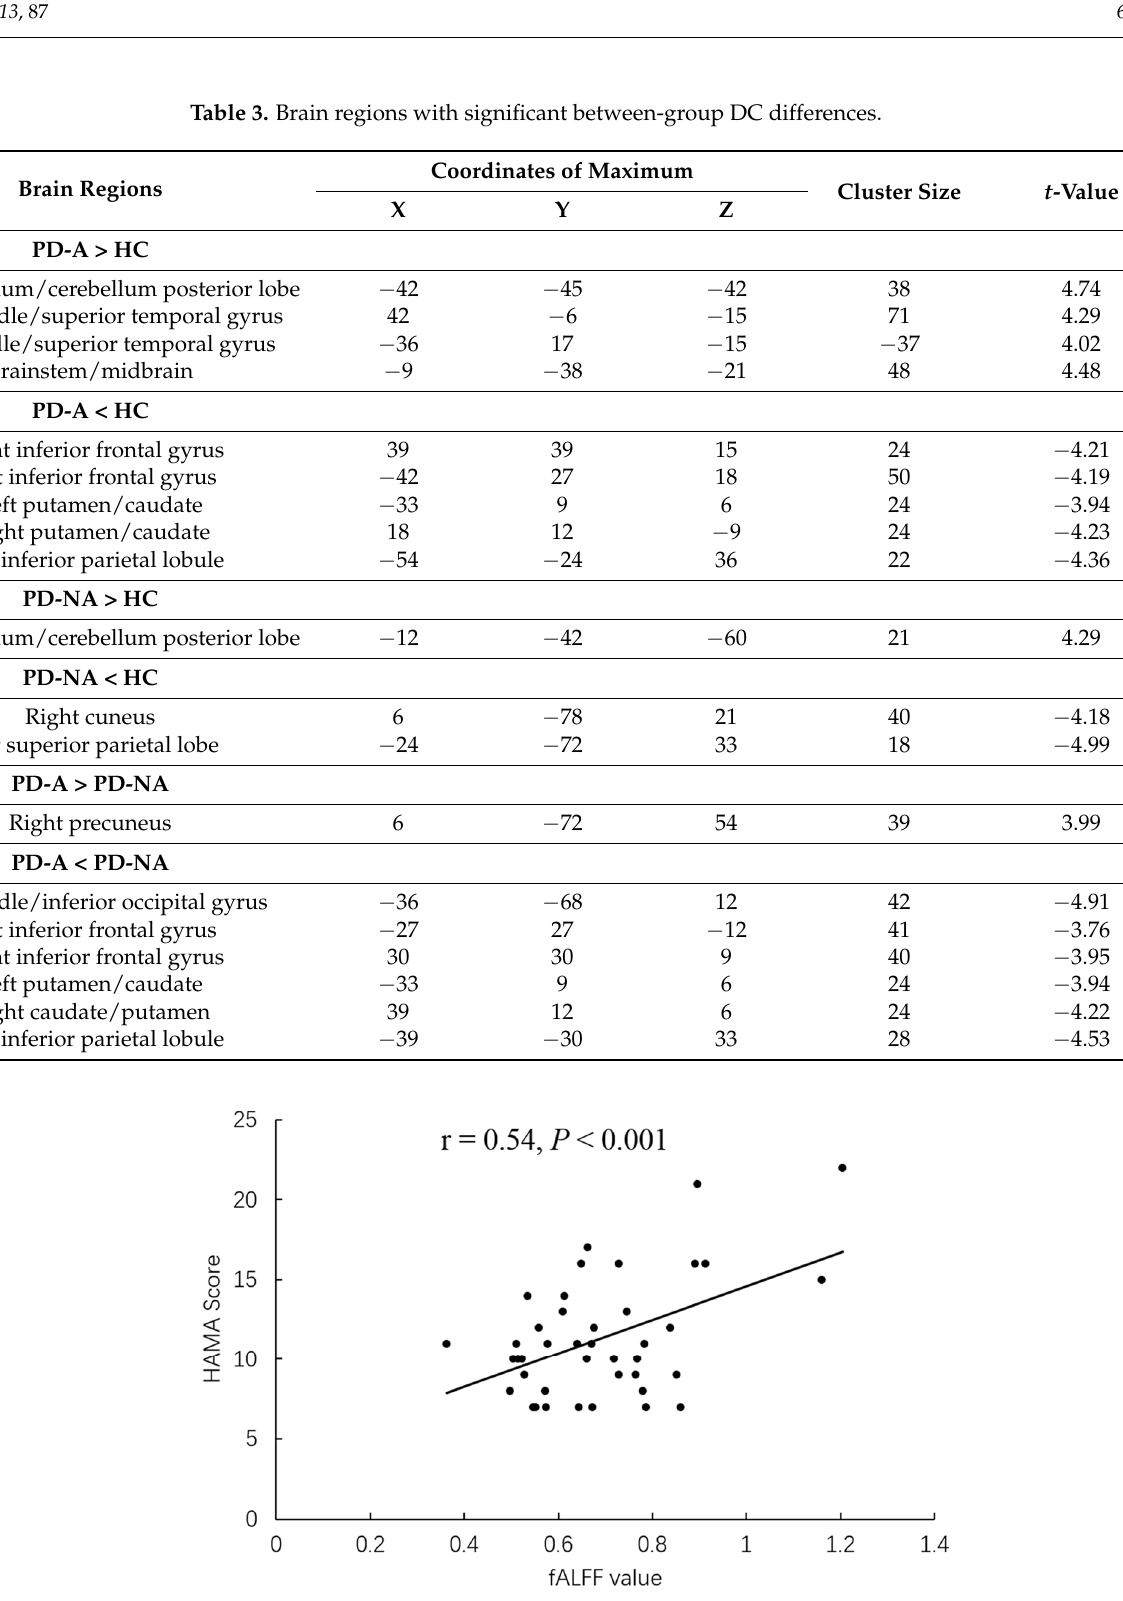
Figure 3. In PD-A patients, the fALFF value of the right precuneus showed a positive correlation with HAMA scores.